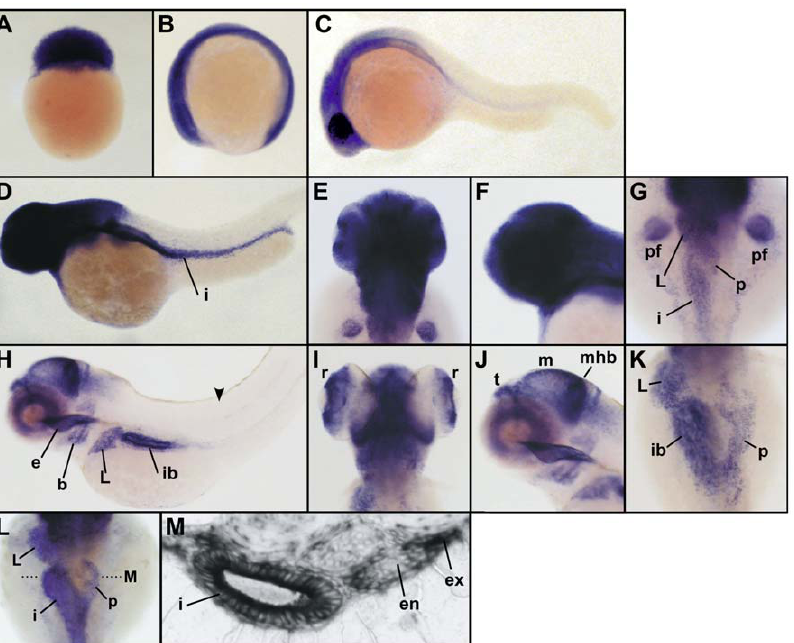
Figure 4. Ddx46 expression in the developing zebrafish. (A–K) Ddx46 expression was examined using whole-mount in situ hybridization in WT embryos or larvae at the 128-cell (A), 6-somite (B), 1-dpf (C), 2-dpf (D–G), and 4-dpf (H–K) stages. Lateral view, animal pole to the top (A). Lateral views, anterior to the left (B, C, D, F, H, J). Dorsal views, anterior to the top (E, G, I, K). The Ddx46 transcript was maternally supplied and continued to be expressed ubiquitously during the somitogenesis stages (A, B). By 1 dpf, Ddx46 expression became restricted to the head region (C). At 2 dpf, strong Ddx46 expression was prominent in the head, pectoral fin bud, and digestive organs (D–G). At 4 dpf, Ddx46 expression was further restricted to the retina, telencephalon, midbrain, midbrain-hindbrain boundary, branchial arch, esophagus, liver, pancreas, and intestinal bulb (H–K). No Ddx46 transcript was detected in the somite (arrowhead in H). (L, M) Ddx46 expression was examined using whole-mount in situ hybridization in WT larvae at 3 dpf. Dorsal views, anterior to the top (L). A transverse section was cut at the level indicated by the black dotted line in L. The section revealed Ddx46 expression in the intestine and exocrine pancreas, but not in the endocrine pancreas (M). b, branchial arches; e, esophagus; en, endocrine pancreas; ex, exocrine pancreas; i, intestine; ib, intestinal bulb; L, liver; m, midbrain; mhb, midbrain-hindbrain boundary; p, pancreas; pf, pectoral fin bud; r, retina; t, telencephalon.